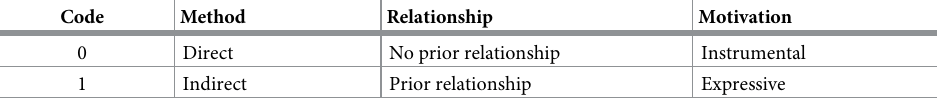
Table 1. Coding scheme for response and explanatory variables used in GLM analysis of cyber abuse.